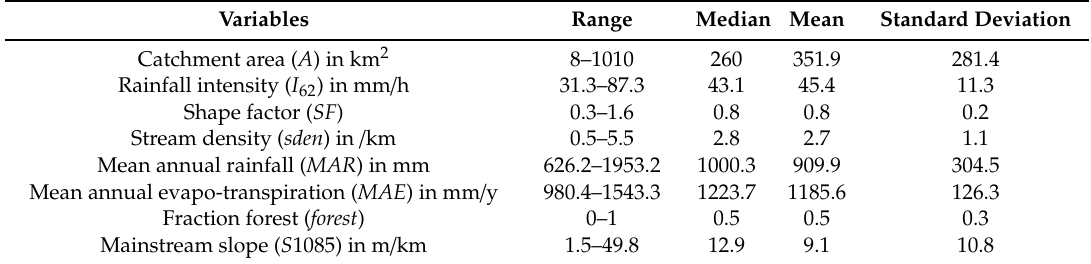
Table 1. Summary of descriptive statistics of selected catchment and climatic characteristics.